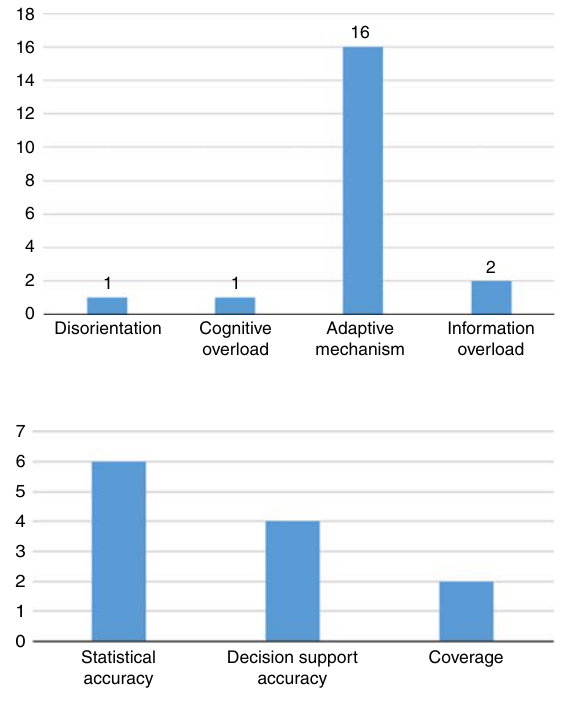
Figure 5. The distribution of evaluation metrics for recommendation